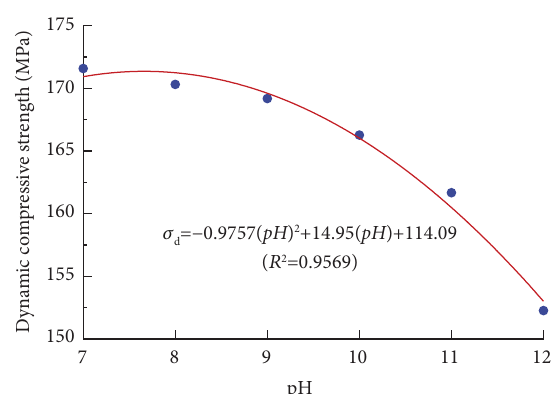
Figure 6: Relationship between dynamic compressive strength and pH.